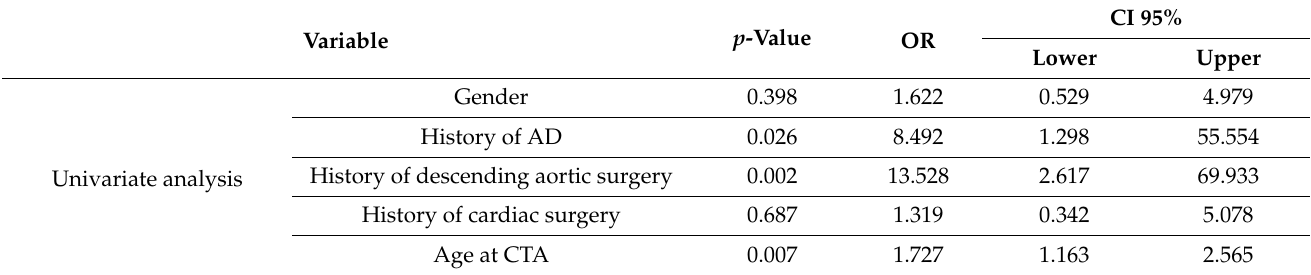
Figure 2. Kaplan – Meier estimates of freedom from aortic dissection for the overall population ( A ) and stratified by gender ( B : men; C : women) for patients with primary non-aortic lesions (PNAL+) and without primary peripheral non-aortic lesions (PNAL-). Curves begin with the patients’ birth dates and end with the dates of the CTAs. Dissection may occur (step) or follow-up end (censoring mark). Table 4. Univariate and multivariate analysis of factors associated with PNAL at baseline .